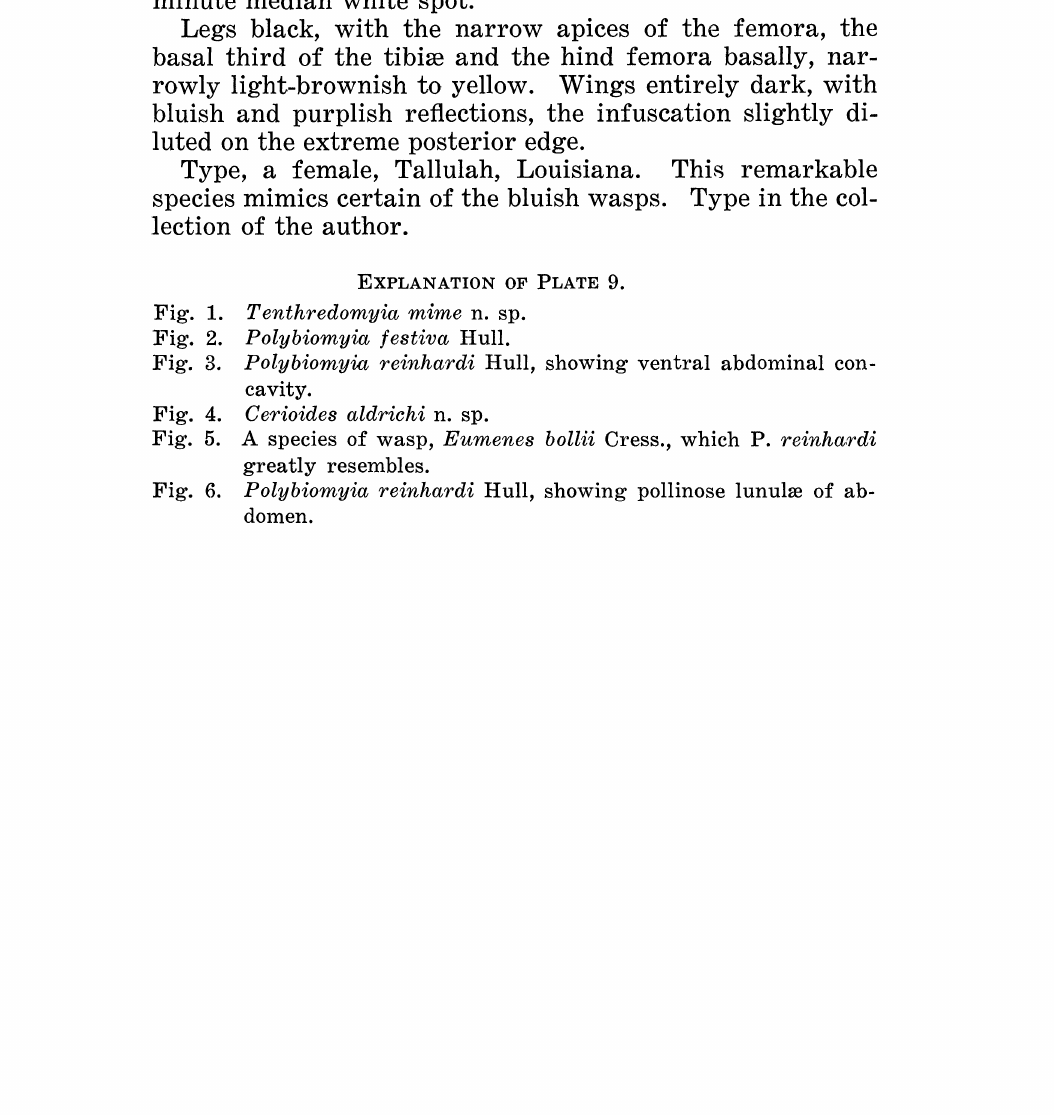
EXPLANATION OF PLATE